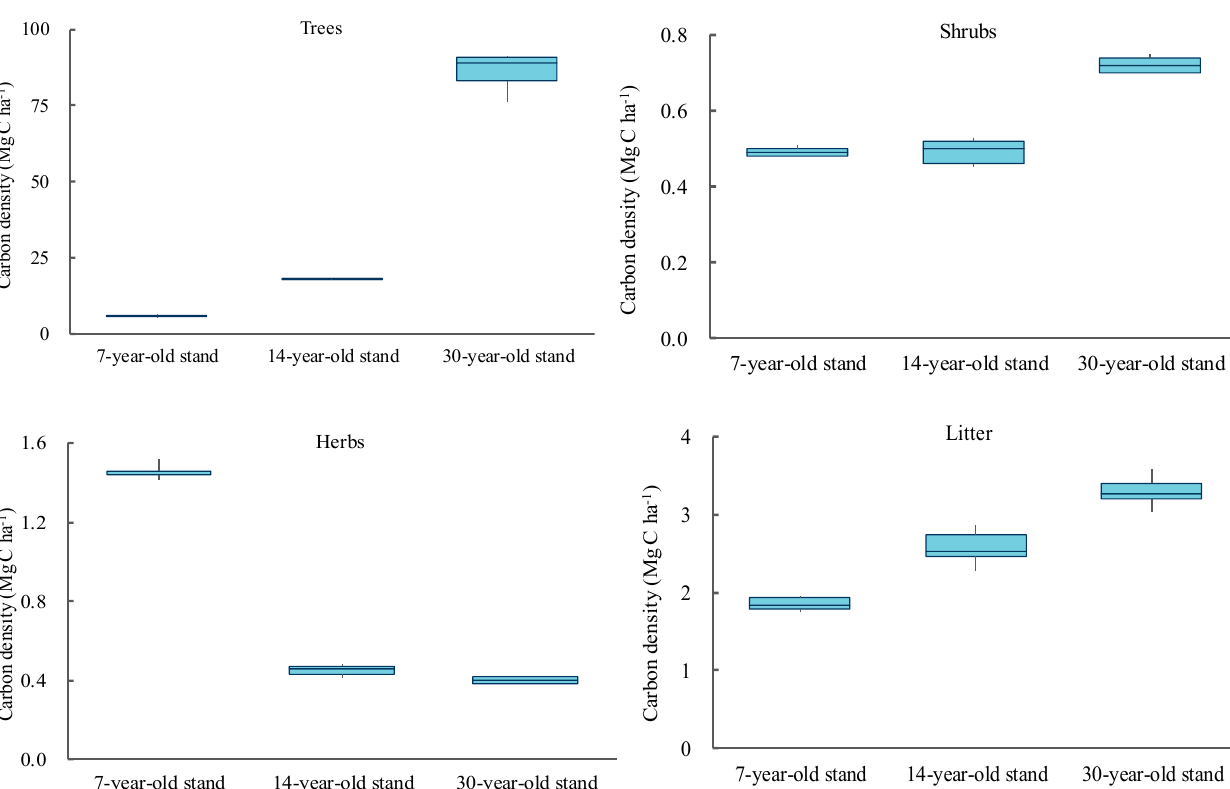
Figure 5. Variability in SOC density across a chronosequence of Masson pine plantations. 3.3. Allocation Proportion of Ecosystem C Stocks The 7-, 14-, and 30-year-old plant systems accounted for 5.86%, 12.81% and 41.21%, respectively, of the total ecosystem C stock (Figure 6a). Trees contributed the largest pro- portion of the plant system C stock in each stand, and shrubs and herbs played a much smaller overall role (Figure 6b). Compared to the plant system, the soil system contained a higher proportion of C stock regardless of forest stand age, especially in the 7-year-old plantation, which had a larger proportion of plant system C stock to ecosystem carbon stock (94.14%) (Figure 6a). The 0–20 cm soil layer contributed the highest proportion of the ecosystem C stock compared to the other soil layers in each plantation (30.18–44.60%) (Figure 6b). The ratio of the plant system C stock to the soil system increased from 0.06 in the 7-year-old plantation to 0.70 in the 30-year-old plantation (Figure 6a).